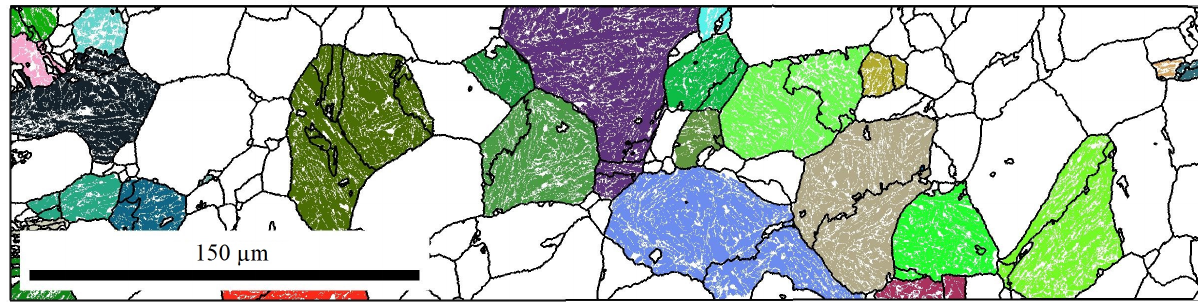
Figure 6. Bainite misorientation corresponding to individual (reconstructed) austenite grains locations, mean values against theoretical orientation relationships — 0 MPa.